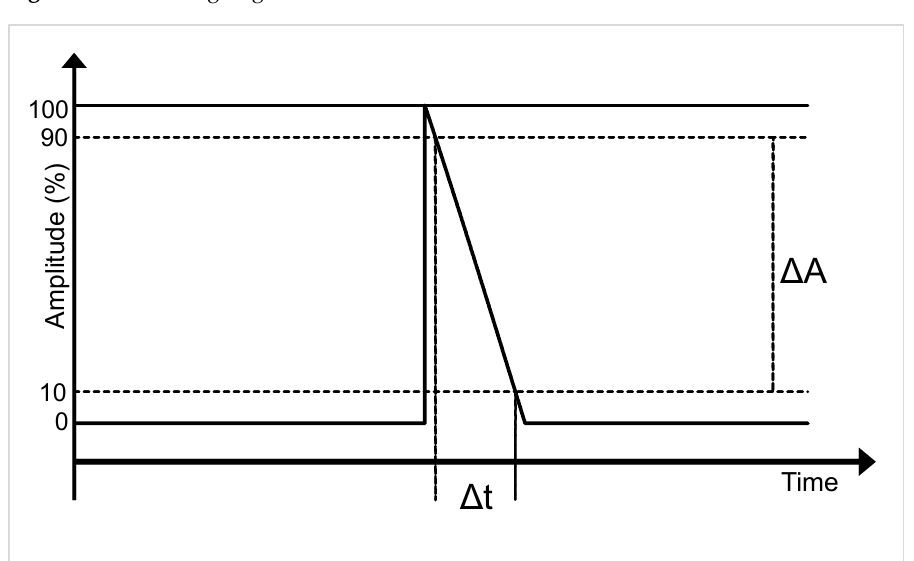
Figure A2. Negative-going